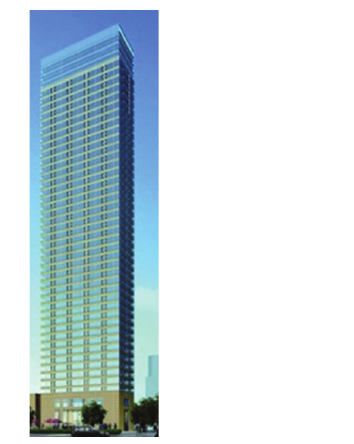
Figure 1: The buildings in Dalian Xinghai Bay Financial Business District.